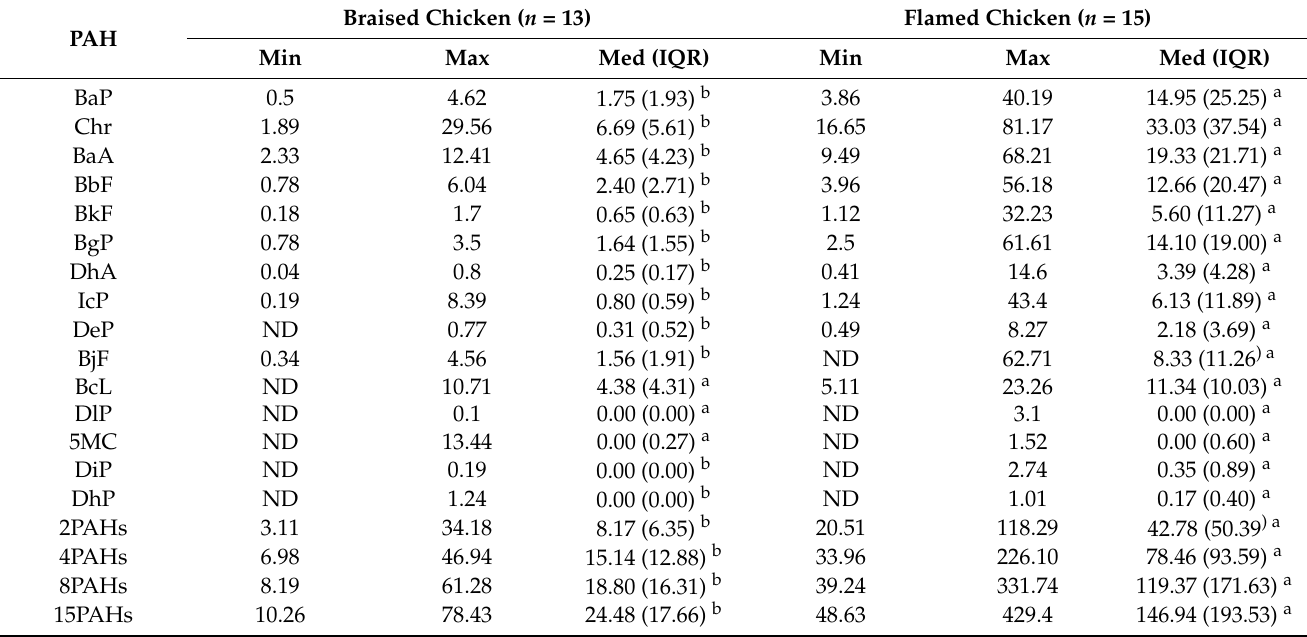
Table 3. Concentrations of PAHs in processed chicken ( µ